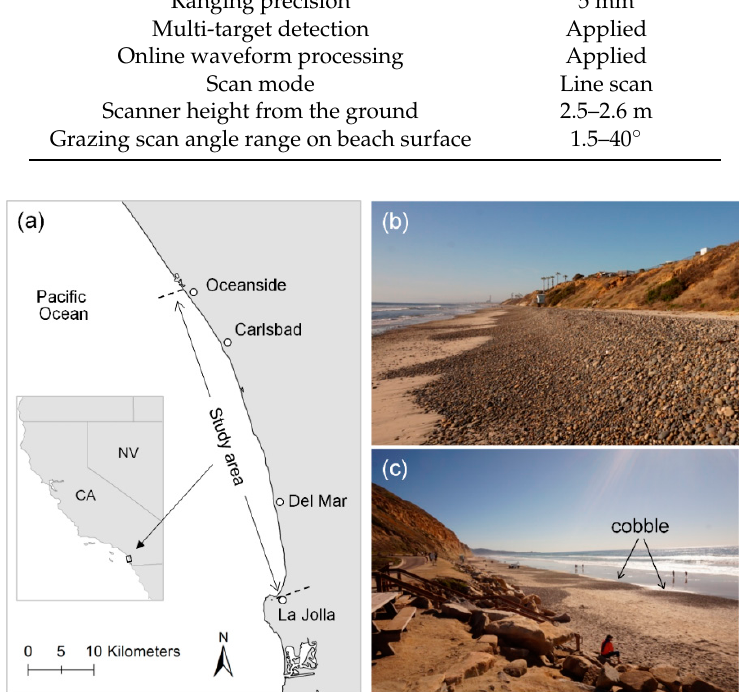
Figure 1. ( a ) Southern California study area and example cobble exposures of ( b ) dense upper-beach cobble berm, and ( c ) mid-beach cobble patches.